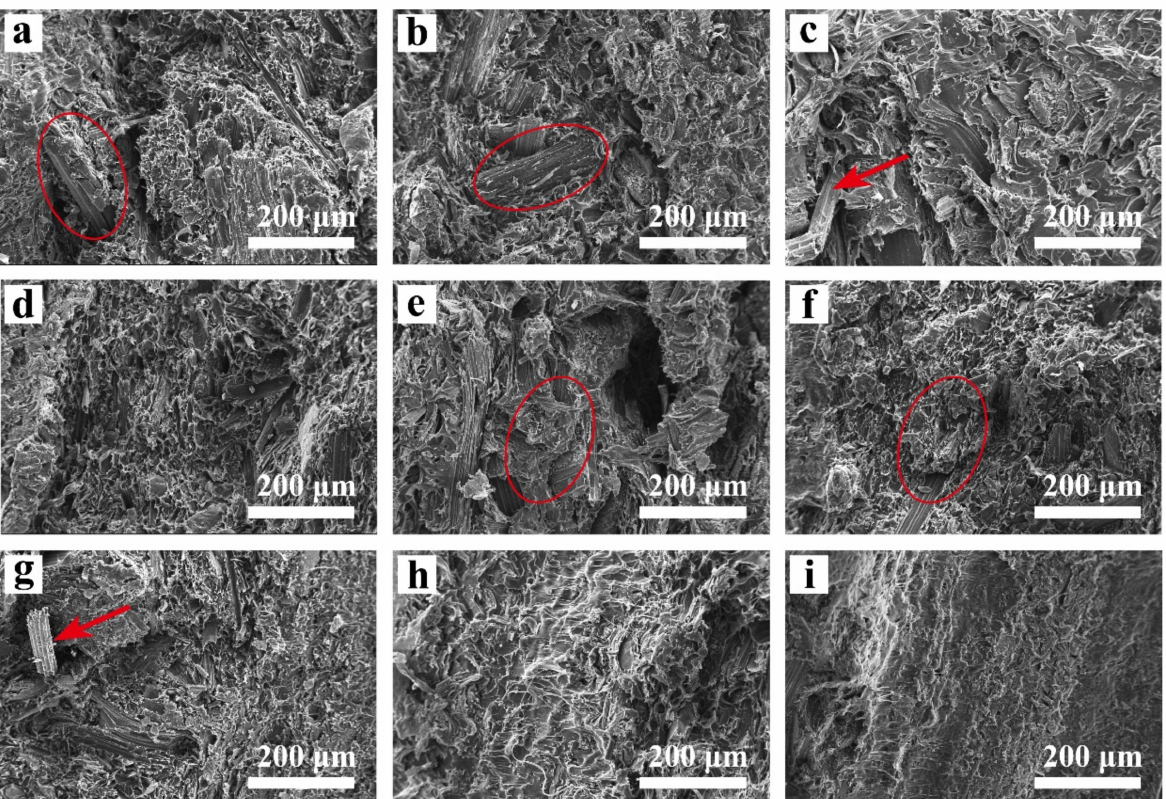
Figure 8. SEM images for the fracture section of CSF/PLA composites with different particle sizes: ( a ) 40 mesh CSFS/CSFC/PLA, ( b ) 40–80 mesh CSFS/CSFC/PLA, ( c ) 80–120 mesh CSFS/CSFC/PLA, ( d ) >120 mesh CSFS/CSFC/PLA, ( e ) 40 mesh CSFS/PLA, ( f ) 40–80 mesh CSFS/PLA, ( g ) 80–120 mesh CSFS/PLA, ( h ) >120 mesh CSFS/PLA, ( i )